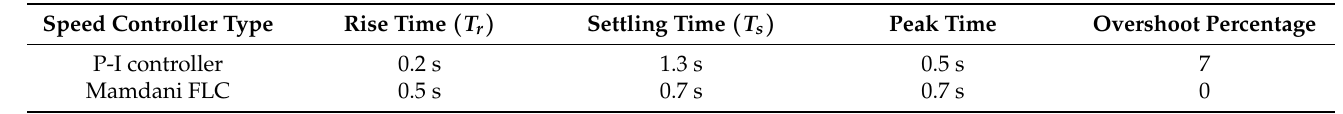
Table 3. Performance comparison between P-I controller and Mamdani fuzzy logic controller (cid:0) (cid:1) medium-speed transition .